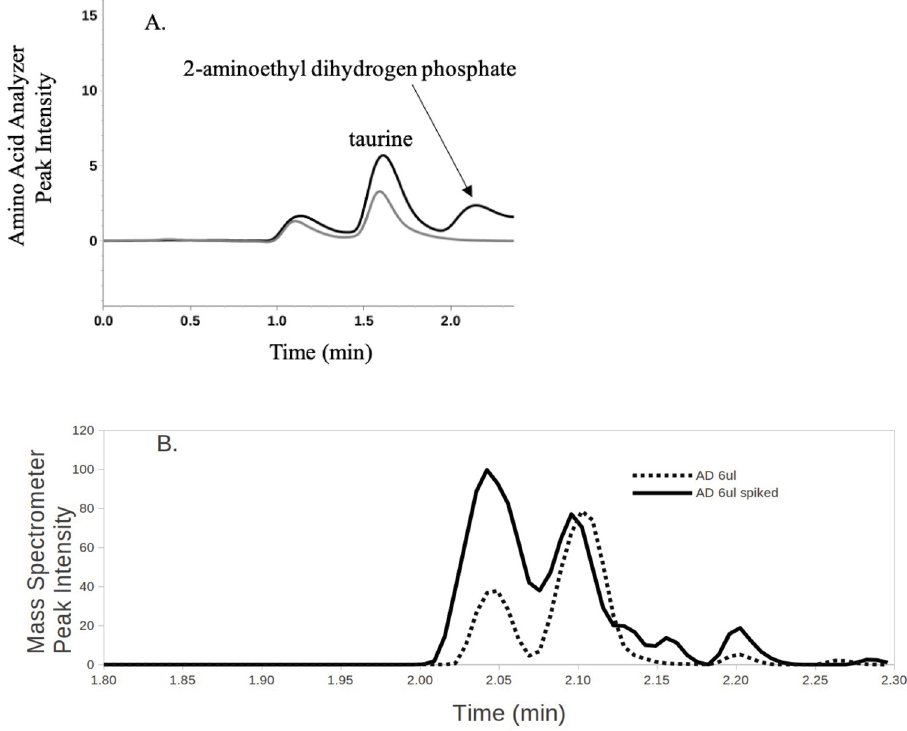
Fig 1. Representative chromatogram from the hitachi Amino Acid Analyzer method. A. Taurine elutes at 1.6 min. 2-aminoethyl dihydrogen phosphate elutes at 2.1 min. Dark line is a representative Alzheimer’s patient sample. Grey line shows the absence of 2-aminoethyl dihydrogen phosphate in a control sample which is considered not detectable. Quantification was achieved by measuring the area under the curve in relation to known standard reference concentrations. B. Representative chromatogram from the tandem mass spectrometer method with 2-aminoethyl dihydrogen phosphate eluting at 2.05 min. The dotted line is an Alzheimer’s patient sample with an injection volume of 6 μ l. The overlaid solid line represents the same sample spiked with a 2-aminoethyl dihydrogen phosphate standard. The identity of the peak at 2.1 min is unknown, however, this peak does not change as a result of the addition of 2-aminoethyl dihydrogen phosphate standard which confirms the identity of the peak at 2.05 min.